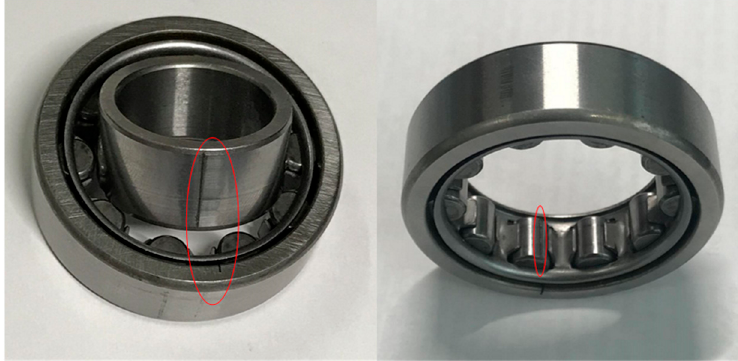
Figure 6. The fault bearing, with defects in (left) inner and our race, (right) rolling element.